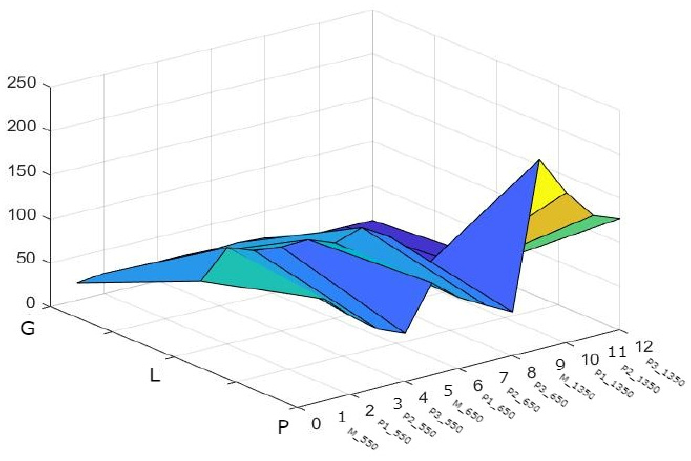
Figure 4. Graphic representation of the main alveograph characteristics.